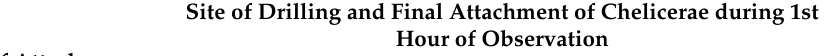
Table 3. Number of Blattisocius mali females that drilled their chelicerae into the cervix, at coxa III or other sites on the thorax or abdomen of D. melanogaster and D. hydei according to the site of mite attack. Site of Drilling and Final Attachment of Chelicerae during 1st Hour of Observation Site of Attack Other Sites tarsus I 7 1 1 tarsus II 1 3 1 1 1 tarsus III 2